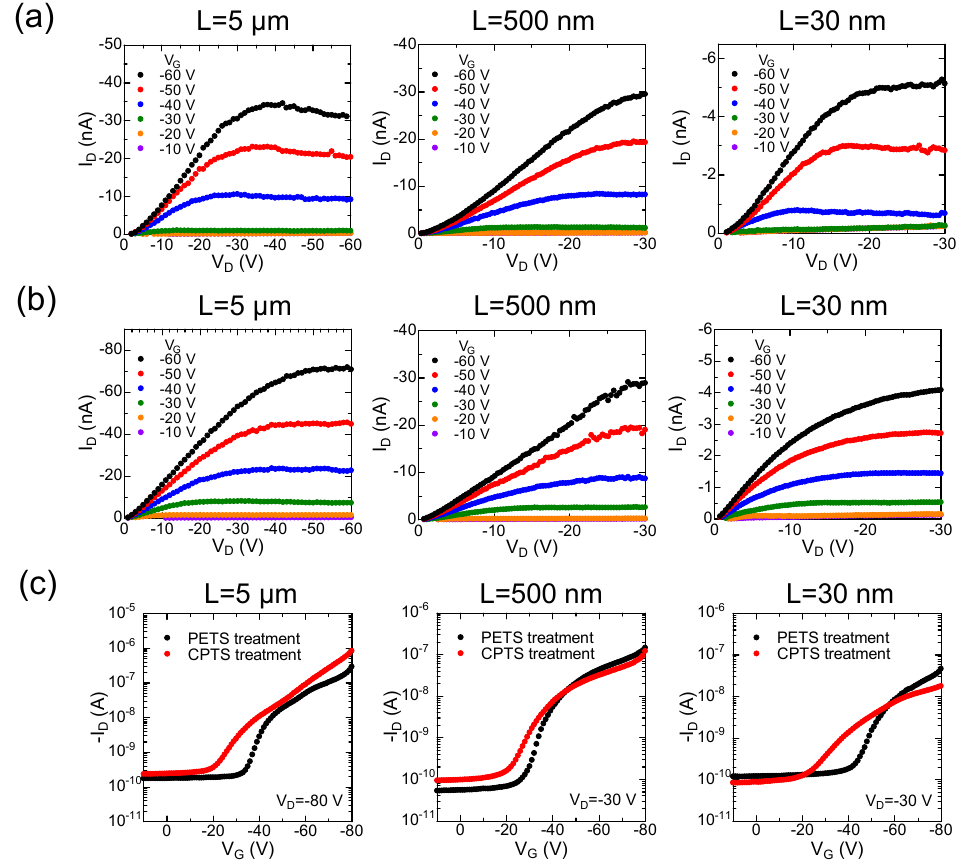
Figure 4. Output characteristics of F8T2 FETs with L of 5 μ m, 500 nm, and 30 nm on 200-nm-thick SiO insulators treated with ( a ) PETS and ( b ) CPTS; and ( c ) their transfer